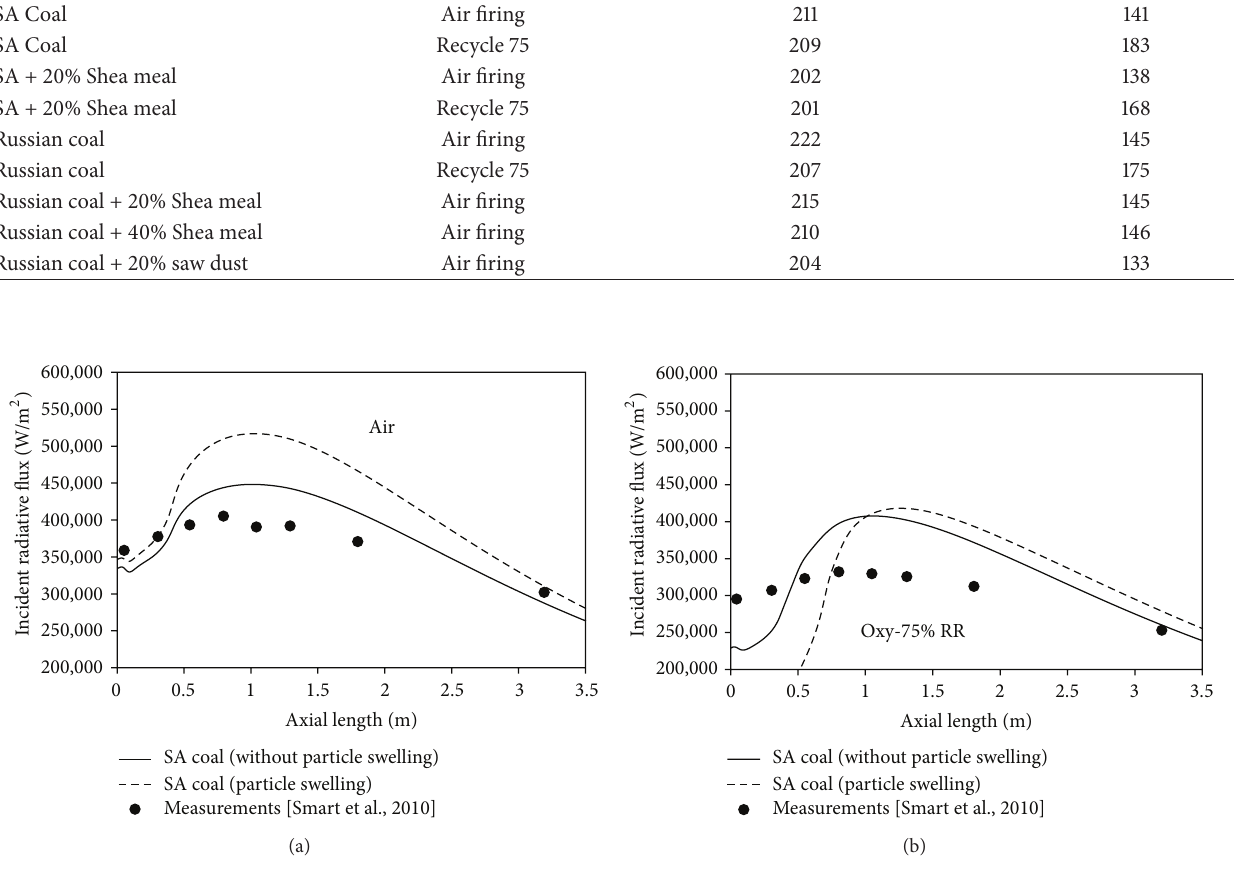
Figure 12: Sensitivities of the incident radiative fluxes to particle swelling during combustion of SA